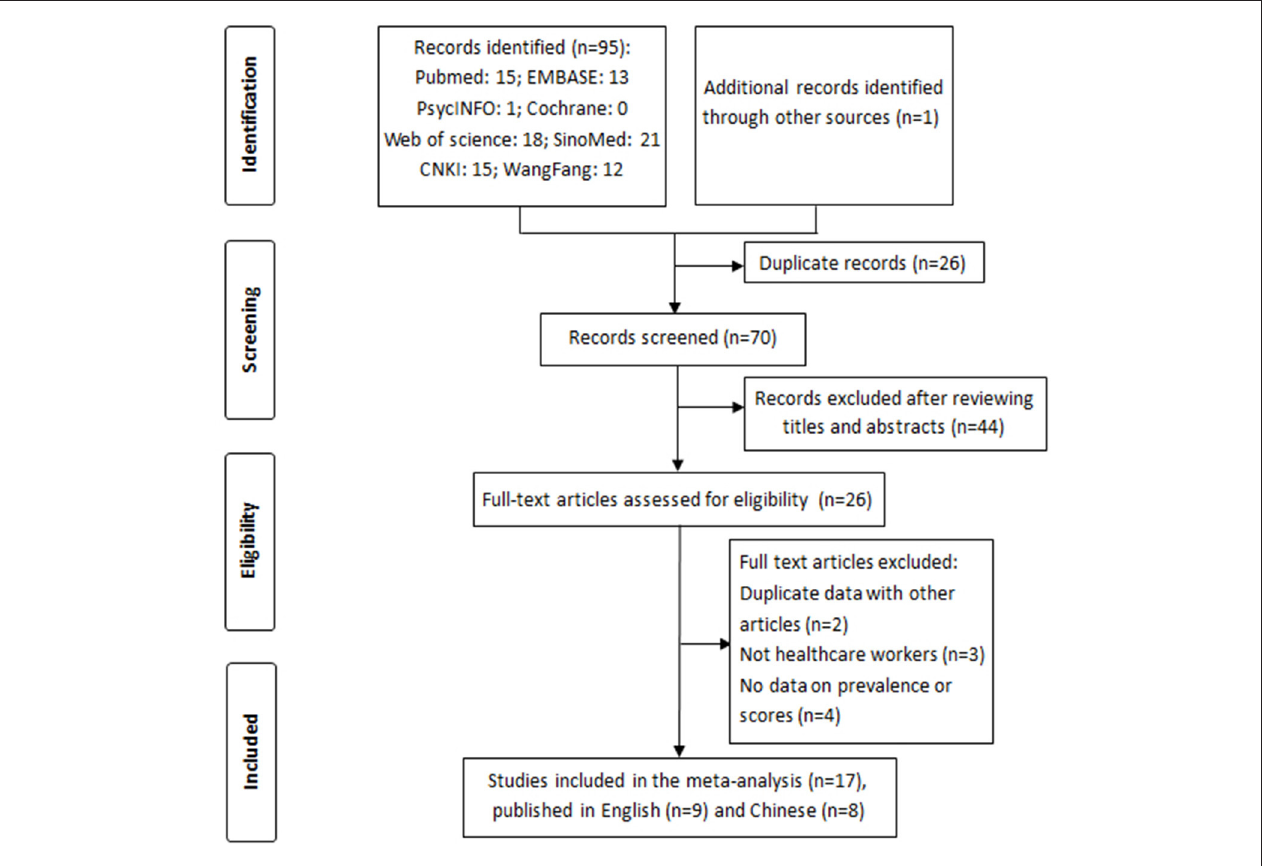
FIGURE 1 | Flowchart of the study selection